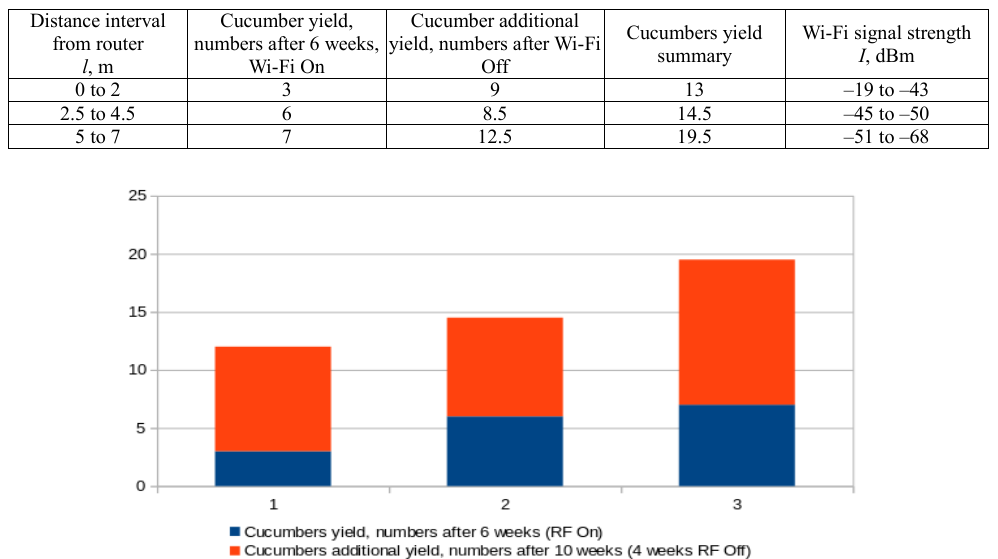
Fig. 2. Number of cucumbers by zone: Zone 1 – 0 m to 2 m from a Wi-Fi router, Zone 2 – 2.5 m to 4.5 m, Zone 3 – 5 m to 7